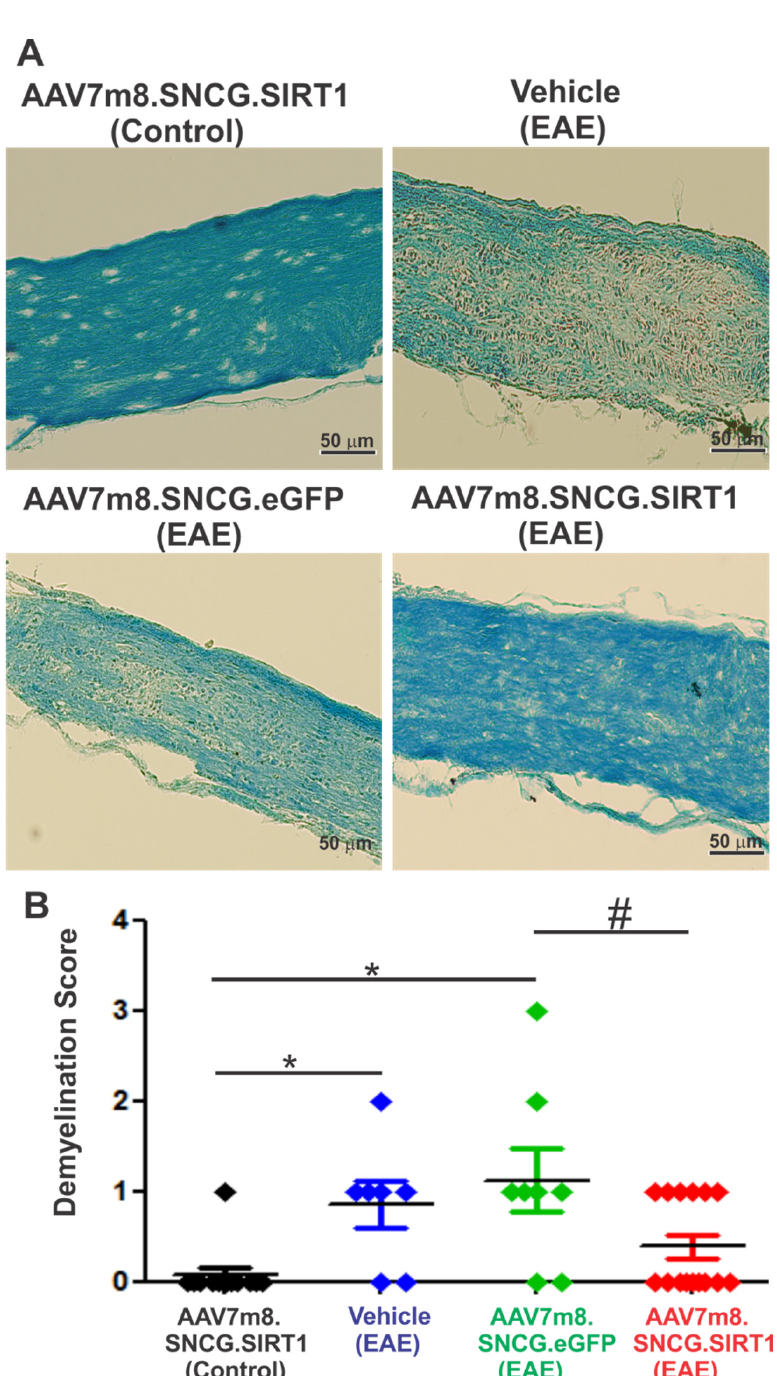
AAV7m8.SNCG.SIRT1-treated mice are shown. Yellow arrows indicate small foci of inflammatory cell infiltrates in representative optic nerve photos. Optic nerve sections were imaged with 20x ob- jective lens. Scale bar, 50 μ m. ( B ) Inflammation scores determined by ratings of the number of infil- trating cell clusters. Data represented as mean ± SEM. * p < 0.05 by one-way ANOVA and Tukey’s multiple comparisons test ( n = 13 for AAV7m8.SNCG.SIRT1 (control); n = 7 for vehicle (EAE); n = 8 for AAV7m8.SNCG.eGFP (EAE); n = 17 for AAV7m8.SNCG.SIRT1). NS = not significant.